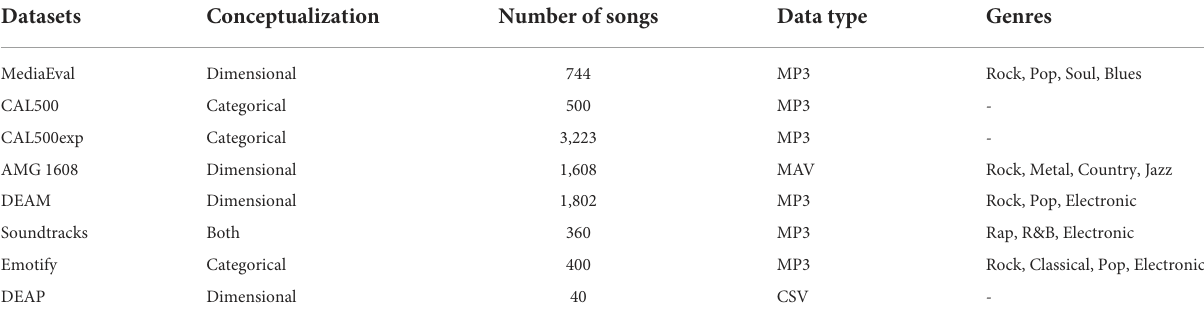
TABLE 1 A summary of